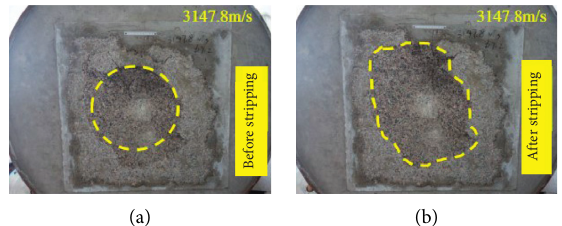
Figure 7: The influence of stripping on the shape of the crater.